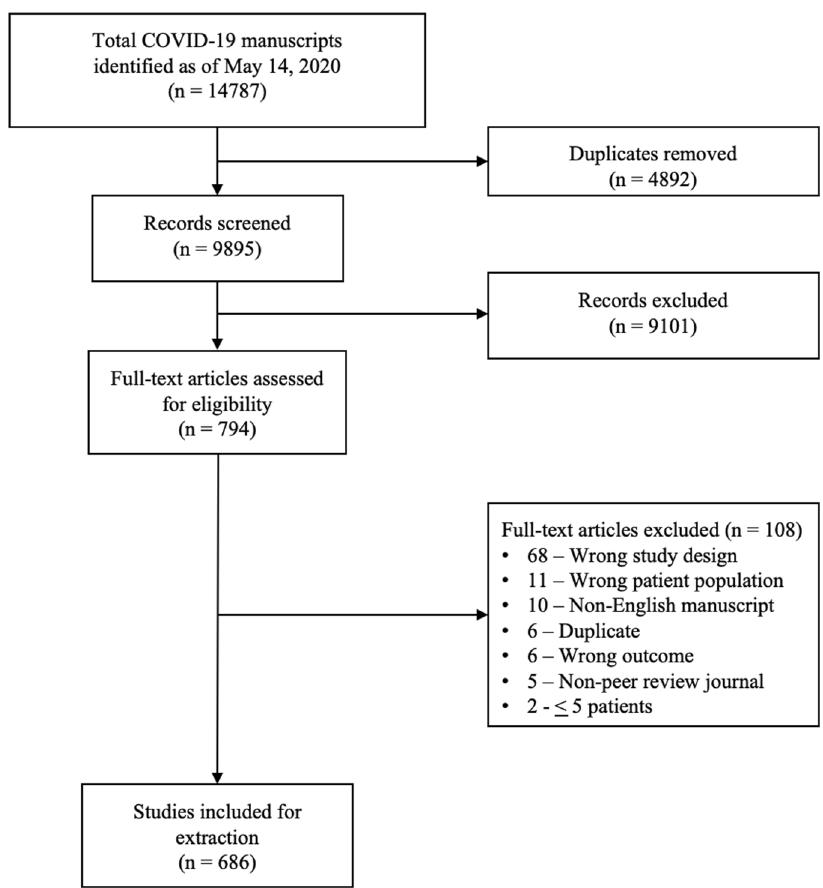
Fig. 1 Literature search and selection of COVID-19 articles. A total of 14787 articles were identi fi ed and 4892 duplicate articles were removed. Overall, 9895 articles were screened by title and abstract leaving 794 articles for full-text screening. Over 108 articles were excluded, leaving a total of 686 articles that underwent methodological quality